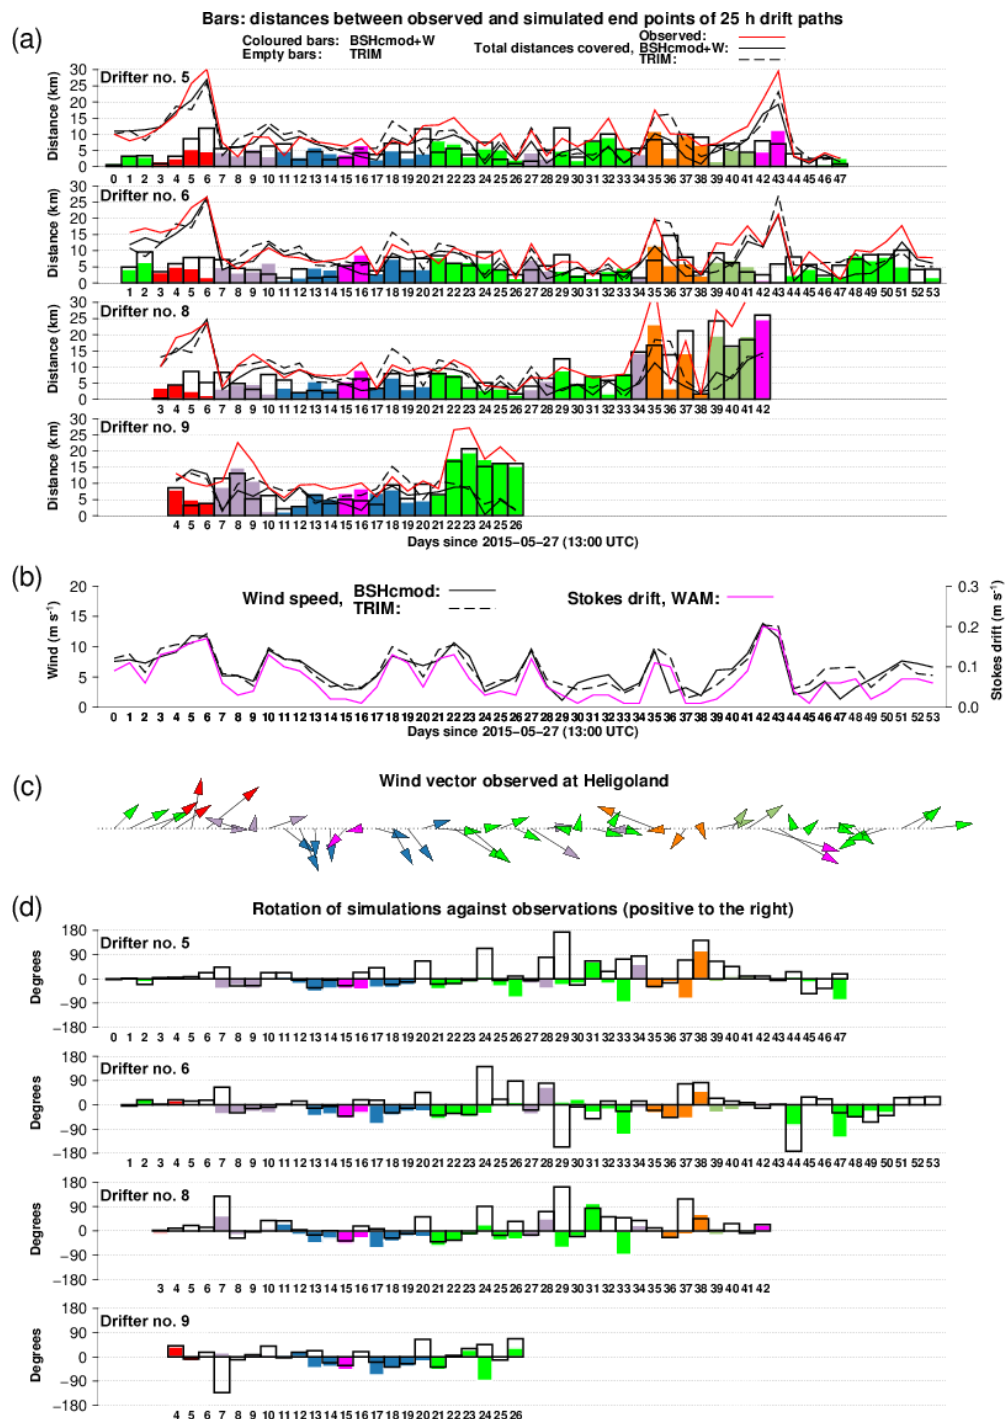
Figure 10. (a) Bars indicate distances between observed end points of 25h drift paths and corresponding simulations based on either BSHcmod + W or TRIM. All drift errors, coloured and labelled in terms of days since 27 May (13:00UTC), are assigned to the centre of the respective 25h period. In addition, lines show total distances travelled. (b) Wind speeds used in the two models and surface Stokes drifts obtained from wave model WAM. Data were extracted for the central example location (55 ◦ N and 7 ◦ E). (c) Heligoland winds, copied from Fig. 3. (d) Angles between observed and simulated tracer displacements. Throughout the figure, all values represent 25h